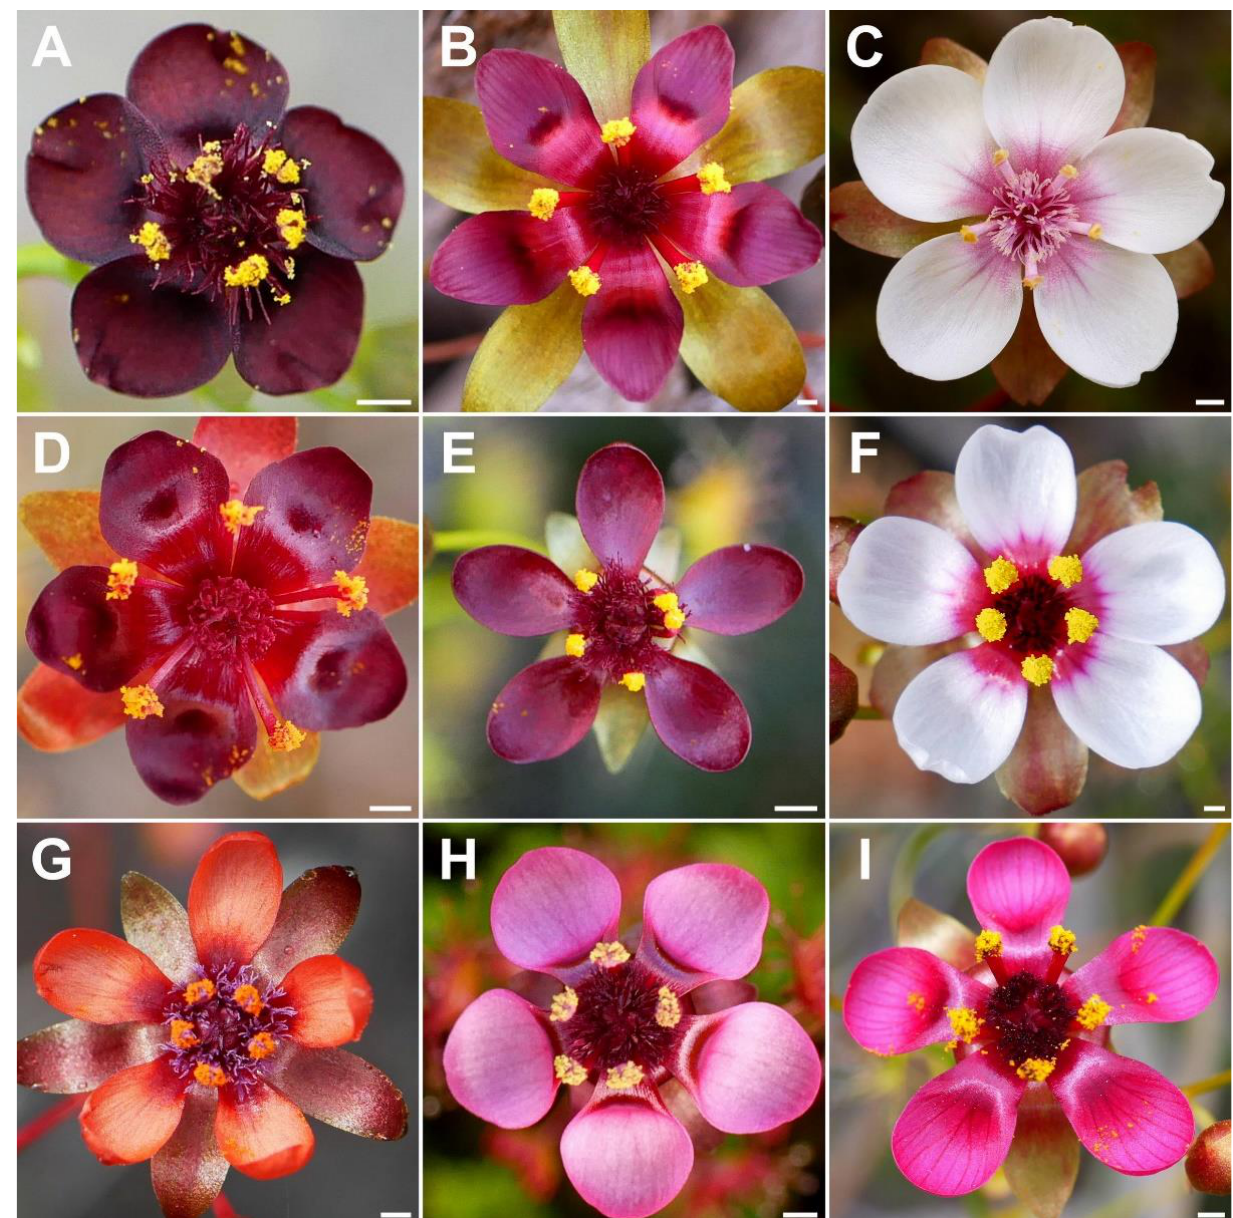
Figure 4. Comparison of the flowers of all nine species of the Drosera microphylla complex. ( A ) D. atrata ; ( B ) D. calycina ; ( C ) D. esperensis ; ( D ) D. hortiorum ; ( E ) D. koikyennuruff ; ( F ) D. macropetala ; ( G ) D. microphylla ; ( H ) D. reflexa ; and ( I ) D. rubricalyx . Scale bars = 1 mm. Images: T. Krueger.